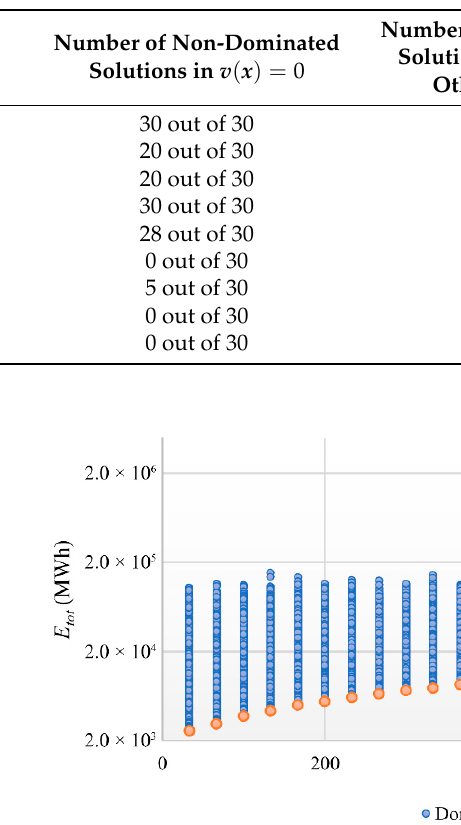
Table 10. Overview of the optimisation results for 1 replication at the neighbourhood scale.